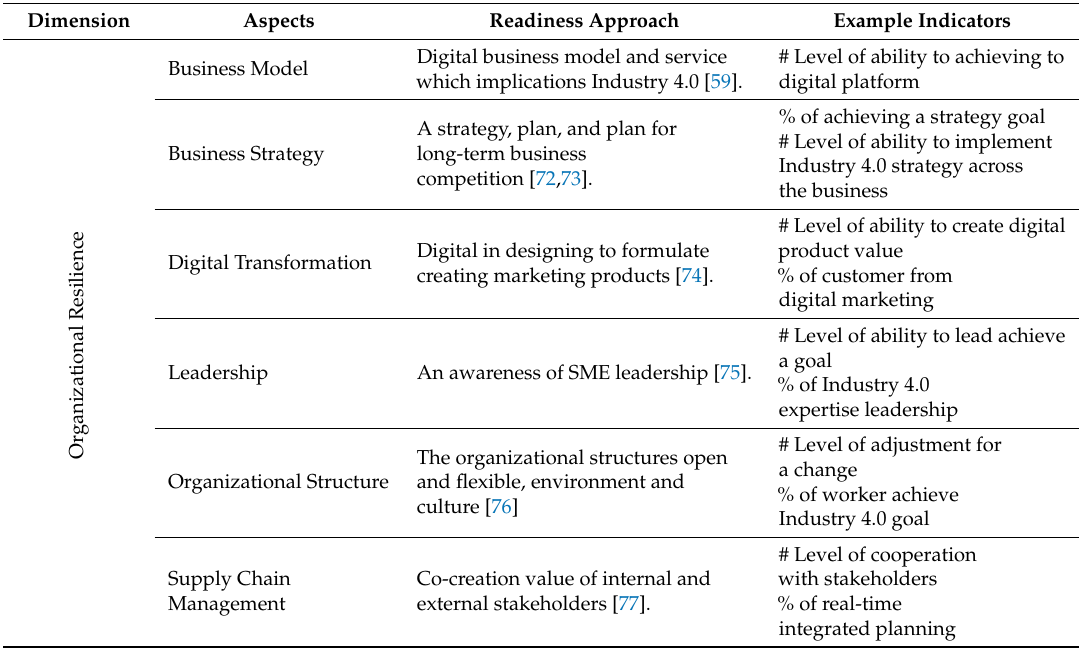
Table 7. SMEs 4.0 readiness